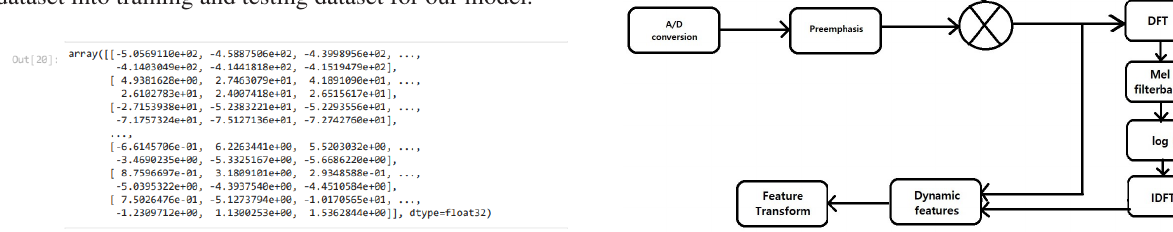
Figure 3: Flow Diagram of MFCC